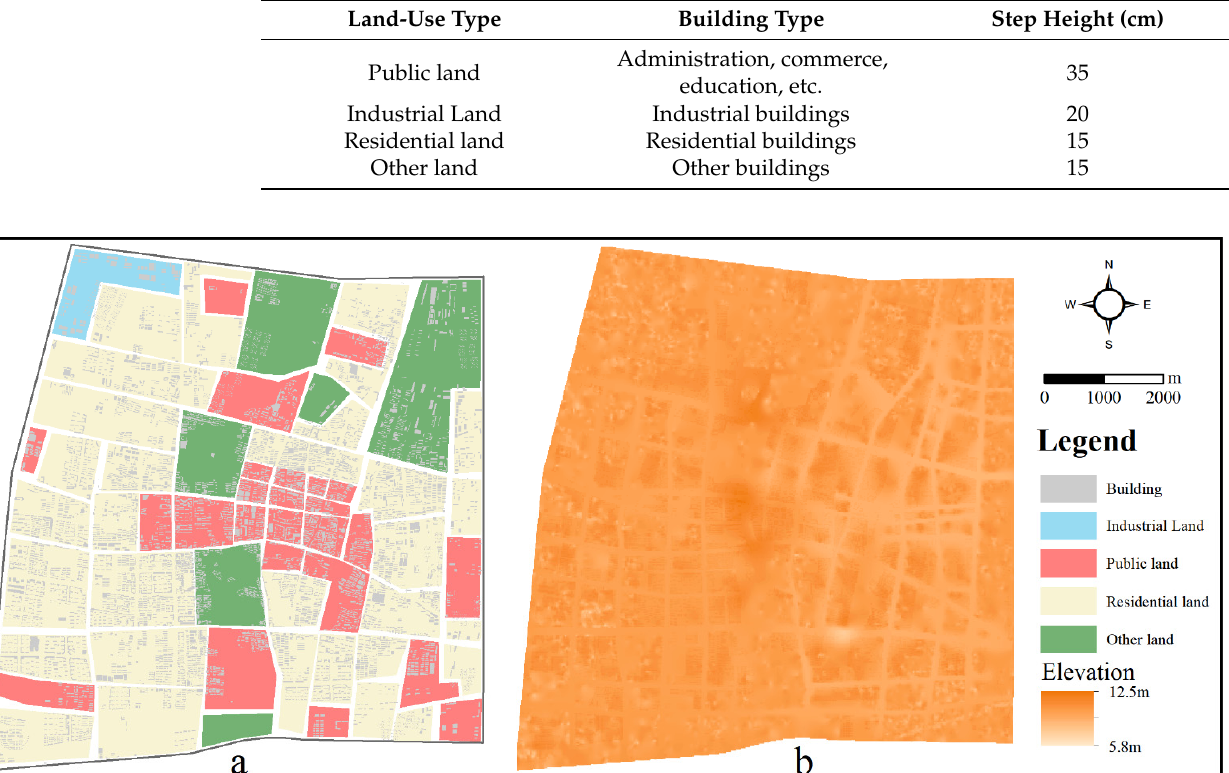
Figure 3. ( a ) Buildings extracted from GF-2 data and land-use type in the study area; ( b ) modified DEM based on buildings.